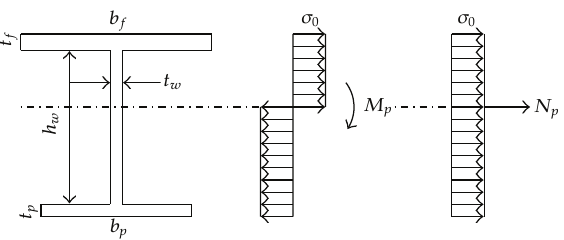
Figure 22: Plastic properties of the